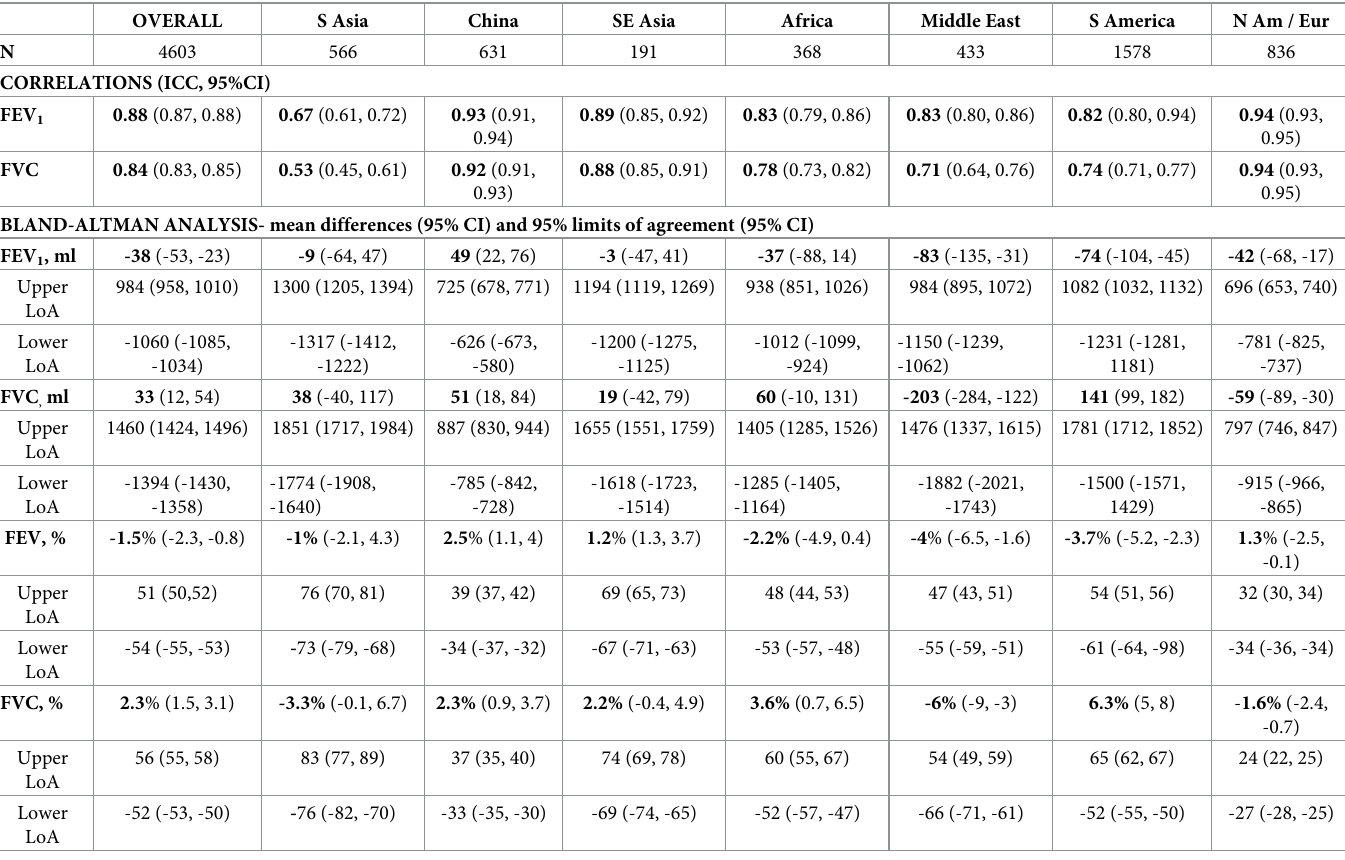
Table 2. Correlations, mean differences and agreement between spirometers by region.